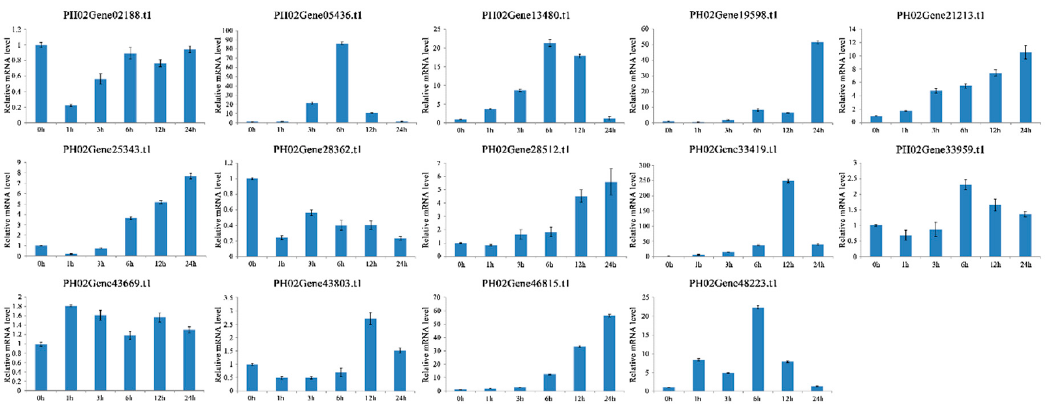
Figure 9. Expression analyses of 14 representative PeUBP genes under MeJA treatment. Sampling